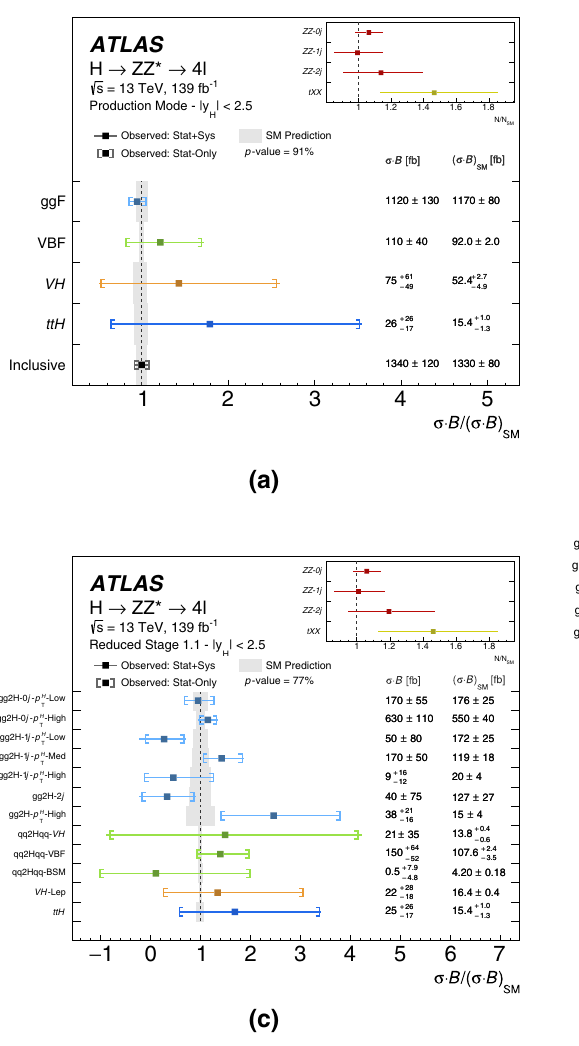
Fig. 10 The observed and expected SM values of the cross-sections ferent Higgs boson production modes (or background sources). The σ · B normalised by the SM expectation (σ · B ) vertical band represents the theory uncertainty in the signal prediction. SM for ( a ) the inclu- The correlation matrices between the measured cross-sections and the sive production and in the Production Mode Stage and ( c ) the Reduced Z Z and tX X normalisation factors are shown for ( b ) the Production Stage-1.1 production bins for an integrated luminosity of 139 fb − 1 at √ Mode Stage and ( d ) the Reduced Stage s = 13 TeV. The fitted normalisation factors for the Z Z and tX X background are shown in the inserts. Different colours indicate dif-